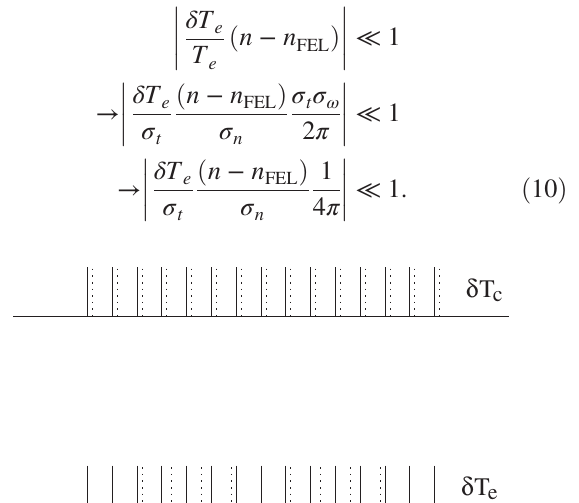
and T in c e will shift the c will change the spacing of the e